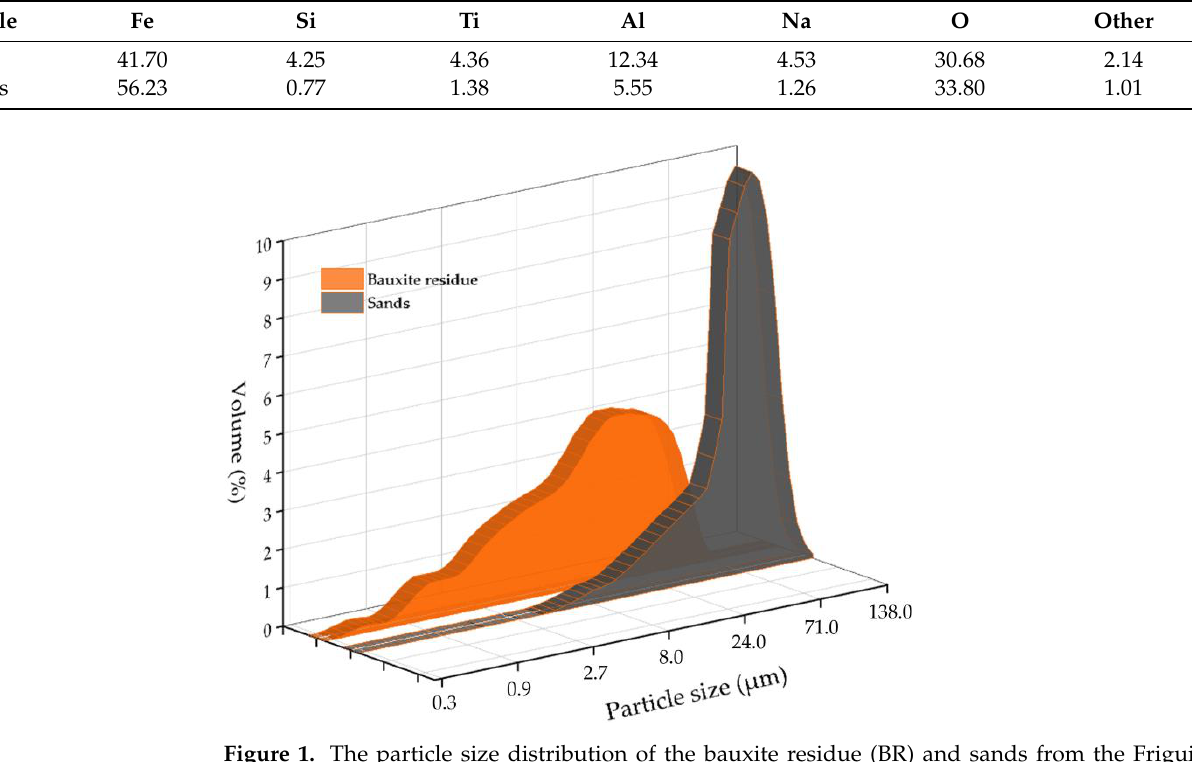
Figure 1. The particle size distribution of the bauxite residue (BR) and sands from the Friguia alumina refinery.